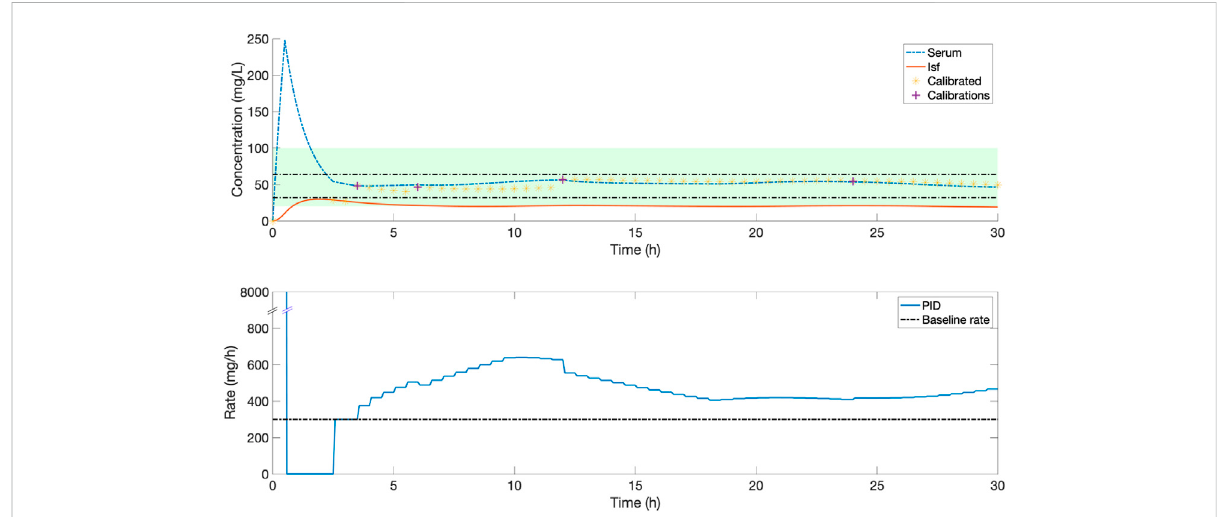
FIGURE 6 An example of the serum and ISF concentration (mg/L) of piperacillin and corresponding IV rate (mg/h) for an in silico patient dosed by closed- loop control. Yellow stars indicate the ISF sensor measurements after they have been calibrated to serum concentrations, purple crosses are the serum measurements used for this calibration. The shaded green zone is the target range, and black horizontal lines indicate the 32 – 64 mg/L evaluation range. In this patient, frequent adjustments by a closed-loop control system maintain a stable serum concentration within the evaluation